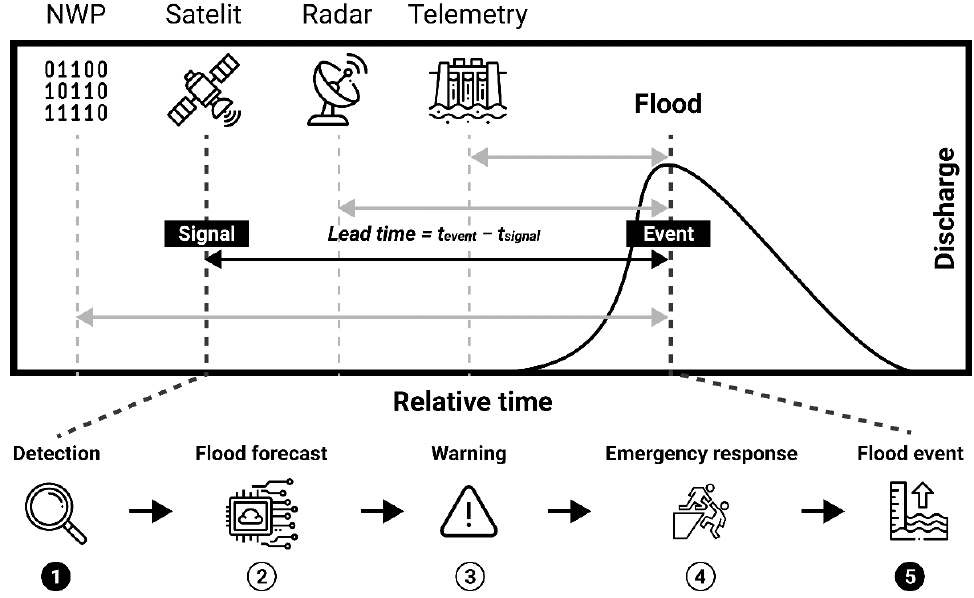
Figure 2. Illustration of the different data type usages to increase flood prediction lead time.